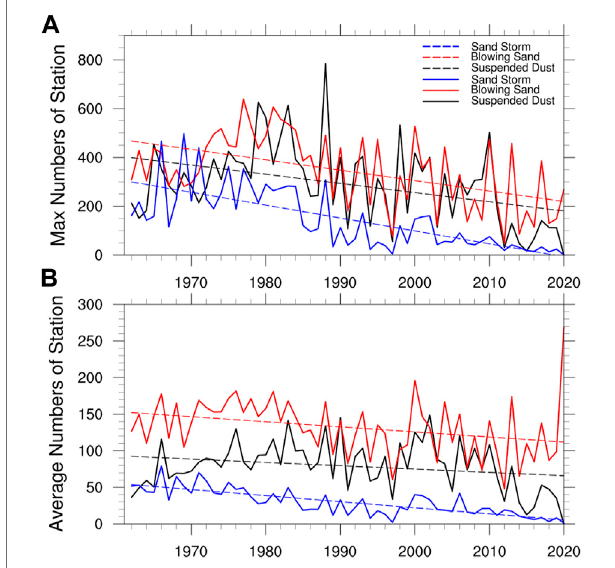
FIGURE 4 | The annual (A) maximum and (B) average number of stations (solid line) for different categories of sand-dust processes, and their linear trends (dotted